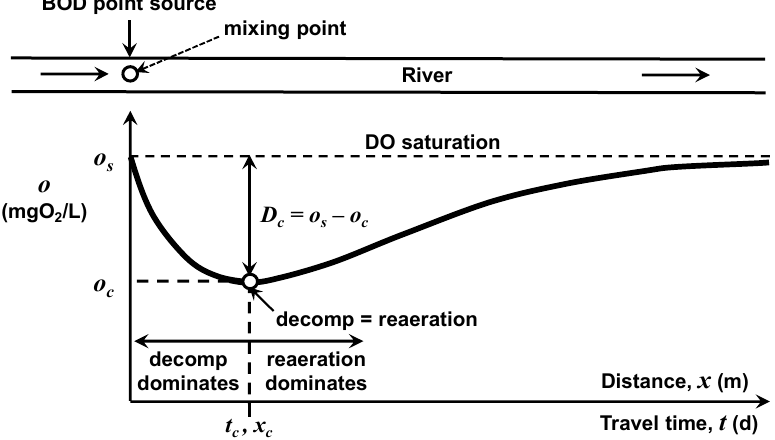
Figure 4. The classic Streeter–Phelps model showing the dissolved oxygen sag in a river below a point source of BOD.